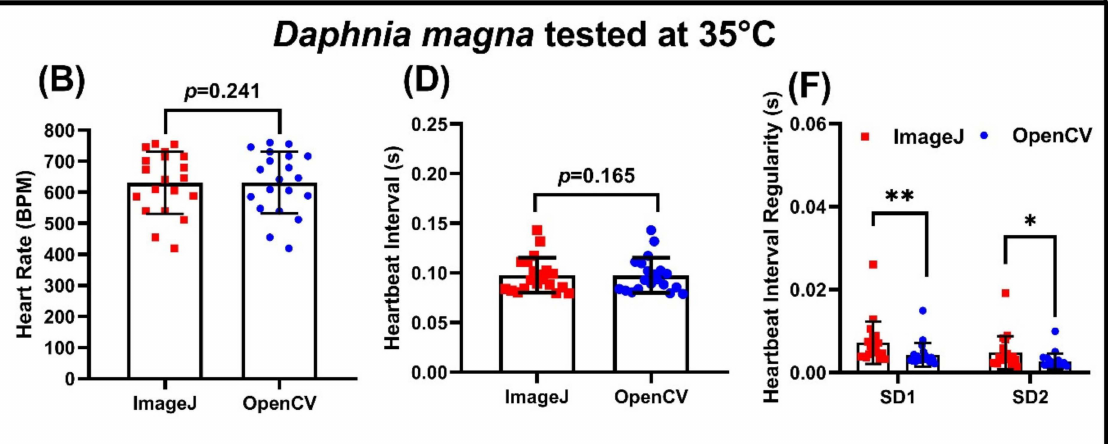
Figure 7. OpenCV can be used to detect an ultrafast heartbeat in Daphnia magna. Comparison of heart rate obtained from at either 15 ◦ C ( A ) or 35 ◦ C ( B ) using ImageJ TSA and OpenCV methods. Comparison of heartbeat intervals at either 15 ◦ C ( C ) or 35 ◦ C ( D ) using ImageJ and OpenCV methods. Comparison of heartbeat regularity at either 15 ◦ C ( E ) or 35 ◦ C ( F ) using ImageJ TSA and OpenCV methods. Data was calculated using Wilcoxon test and presented as Mean ± SD, n = 20 (* p < 0.05; ** p < 0.01; *** p < 0.001).